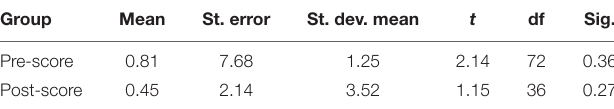
TABLE 8 | Pair sample test (control class).